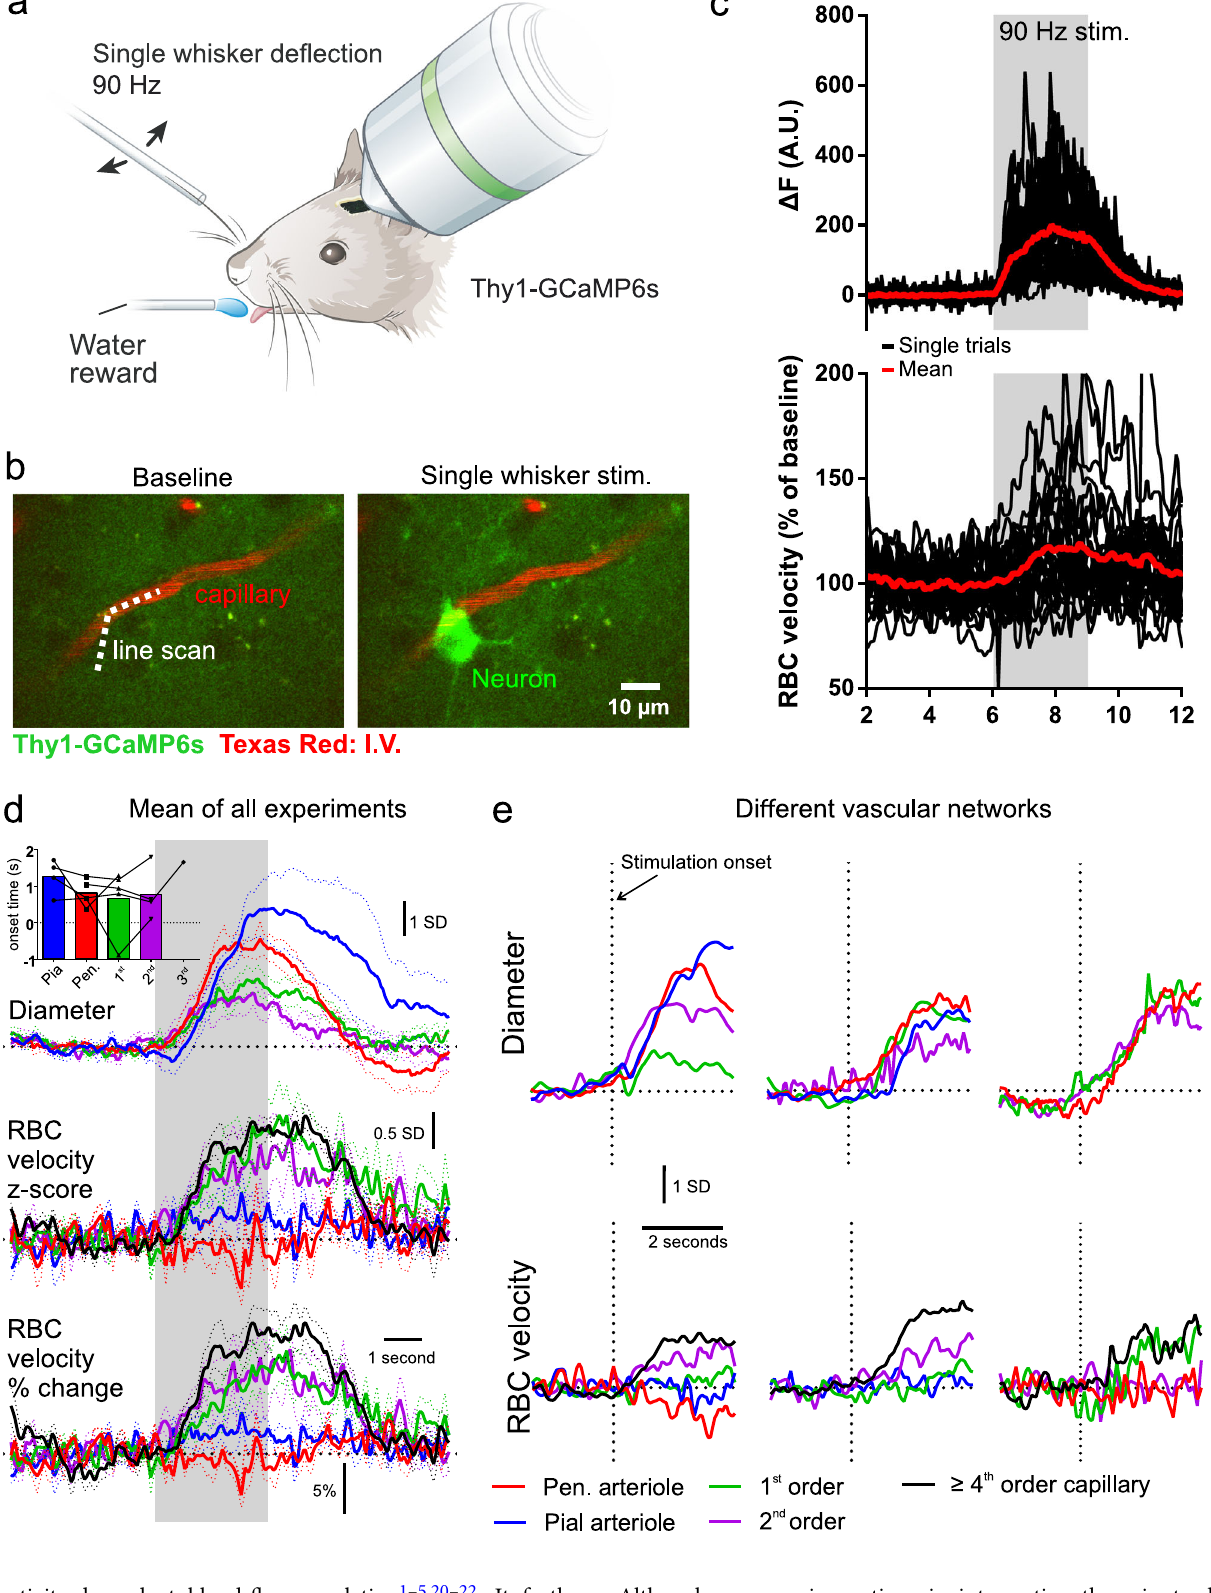
Although, we remain cautious in interpreting the minute dia- meter changes observed in high-order capillaries, when averaged across all mice they appeared delayed. Even if passively driven by increased pressure, given their high resistance this would be expected to produce meaningful increases in blood fl ow 1,23